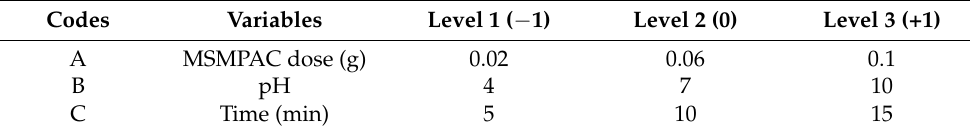
Table 1. Codes and actual variables and their levels in